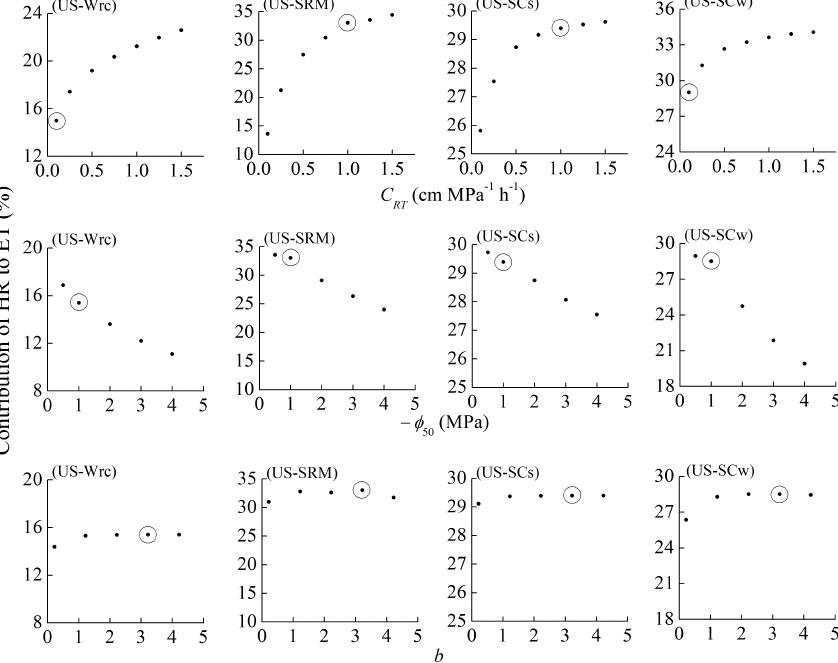
Figure 10. Sensitivity of simulated contribution of HR to ET (defined in Table 6) to selected parameters in the HR scheme of Ryel et al. (2002). Circled parameter set was used in Table